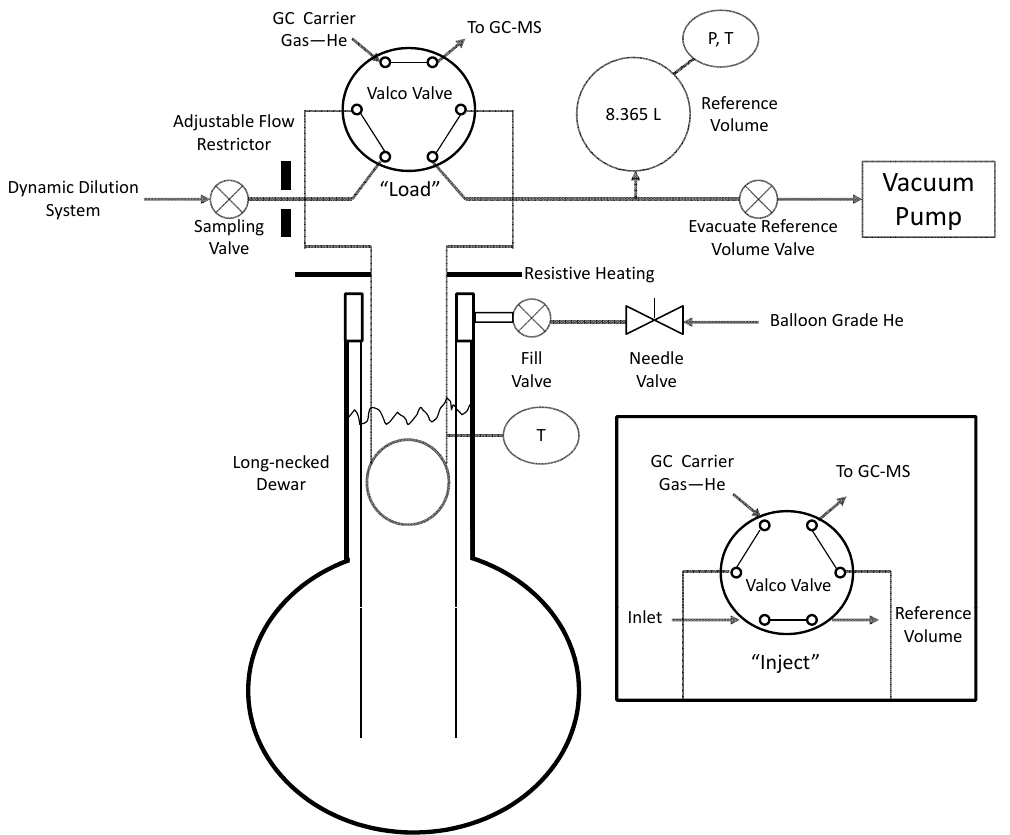
Fig. 3. Schematic of the automated sampling/cryotrapping system used to analyze terpenoid standards generated with the dynamic dilution system. The figure is shown in the “load” sample position. The inset illustrates the valve connections while in the “inject” sample position.